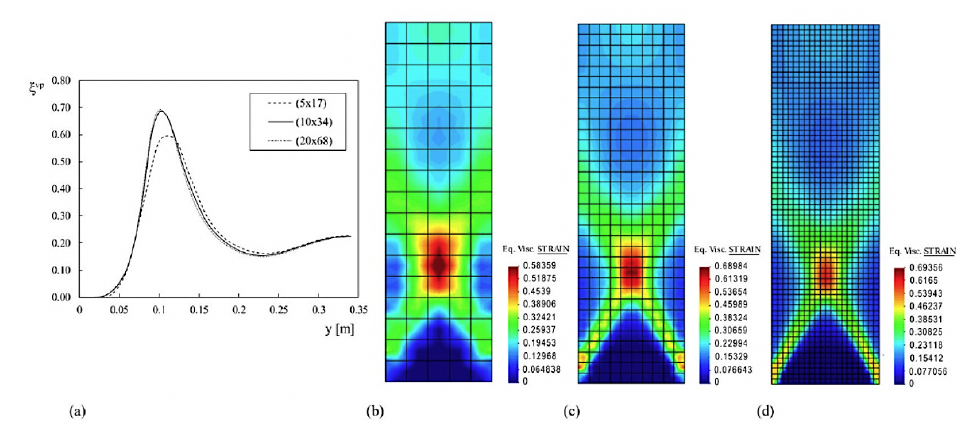
Figure 1. Equivalent viscoplastic strain profiles (a) and contours for (b) coarse mesh (5 × 17), (c) intermediate mesh (10 × 34) and (d) fine mesh (20 × 68) in the case viscosity η = 30 s.